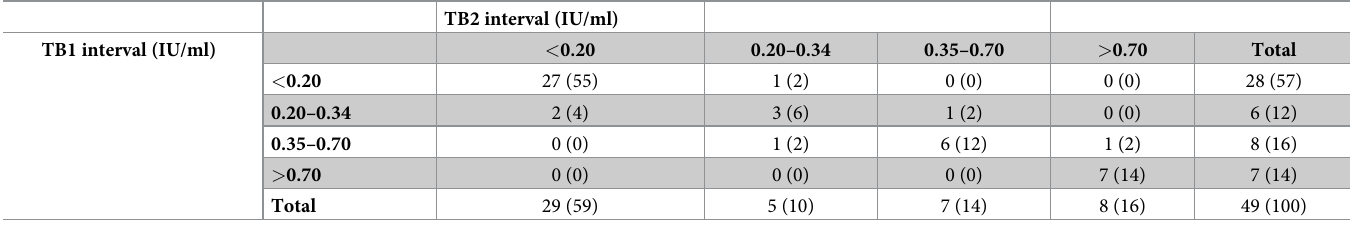
Table 4. Distribution of 49 HIV-positive women with respect to the conventional cut off 0.35 IU/ml and a borderline range (0.20–0.70 IU/ml) in TB1 and TB2. TB2 interval (IU/ml) TB1 interval (IU/ml)